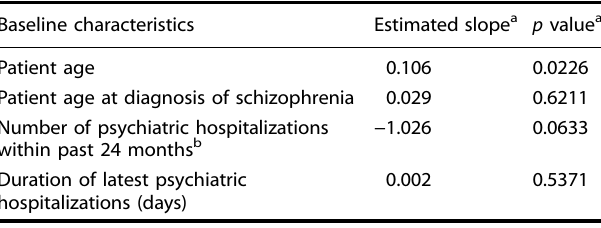
Table 2. Relationship between change in IEQ total score and baseline characteristics (continuous variable)